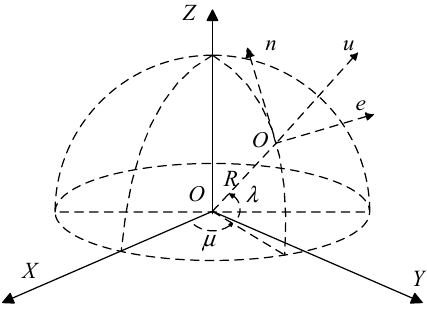
Figure 2. Target measurement in the radar observation coordinate system. The origin O is the